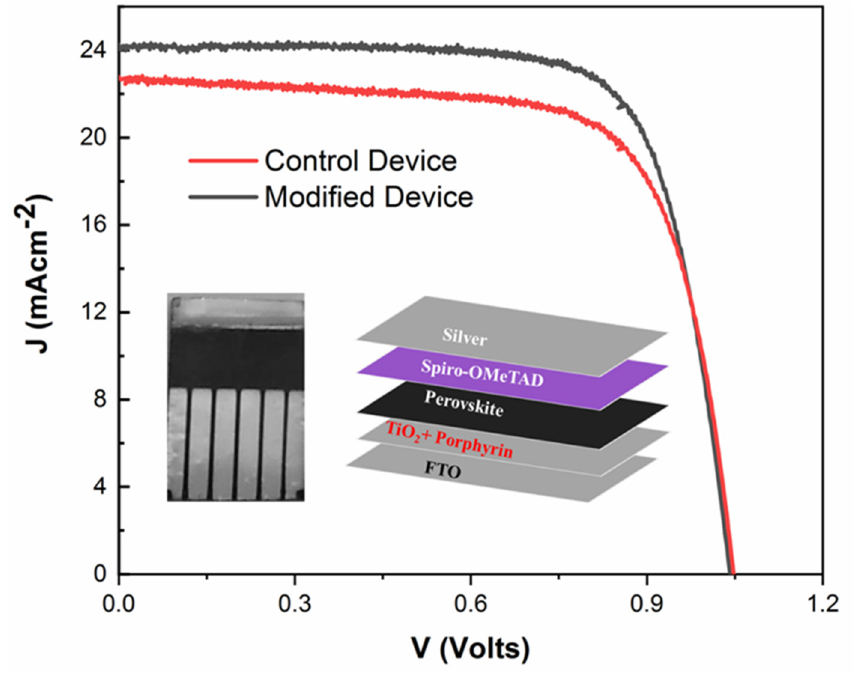
Figure 1. Current density–voltage curves of control and modified PSCs with device structure (inset).